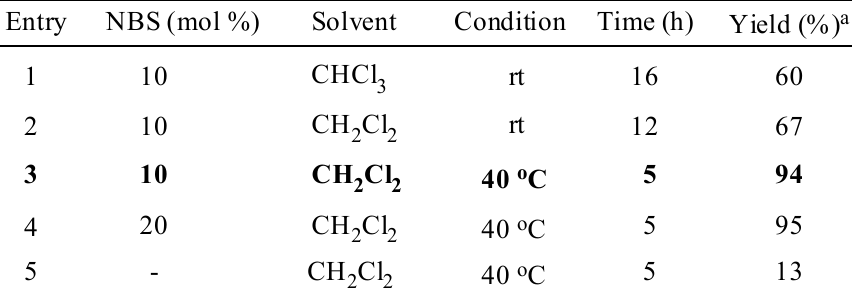
Table 1. Optimization studies of the alkylation reaction of indole and β